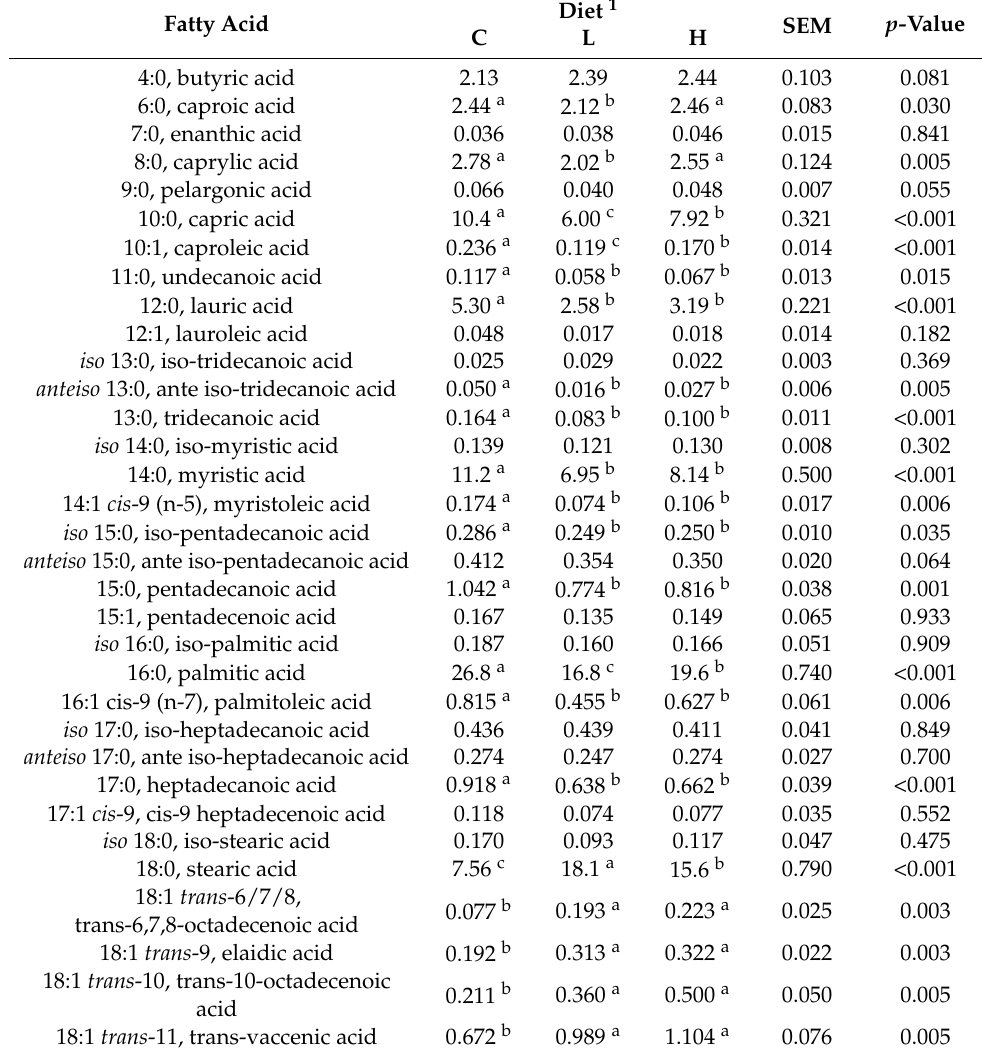
The milk fatty acid composition, expressed as g/100 g of total FA, is reported in Table 6. The sum of saturated linear chain fatty acids (SFA) was higher for C, followed by H and finally by L (70.9, 63.9, and 58.7%, respectively; p < 0.001). Linseed and hemp diet reduced C:16:0, C:14:0, and C:10:0 fatty acids compared to C ( p < 0.001). The amount of monounsaturated fatty acids (MUFA) was higher for L, intermediate for H, and lower for C diet (33.3, 29.6, and 22.4%, respectively; p < 0.001). Oleic acid was increased by L and H ( p = 0.003). The sum of polyunsaturated fatty acids (PUFA) was increased only by L, whereas no difference was seen between H and C (4.79, 3.65, and 3.52%, respectively; p = 0.004). ALA, as expected, was highest in L ( p < 0.001), due to its high content in linseeds. On the contrary, no differences were registered for LA among diets, despite the high LA content of hemp. The n-6/n-3 ratio was statistically influenced by treatments, with L having the lowest value (1.21) and C the highest (5.43) ( p < 0.001). The amount of preformed FA (>C:16:0) was significantly increased by L, followed by H, whereas C recorded a lower value (57.5, 50.1, and 34.7% respectively; p < 0.001). Table 6. Milk fatty acid (FA) composition (g/100 g of total FA) as affected by the three experimen- tal